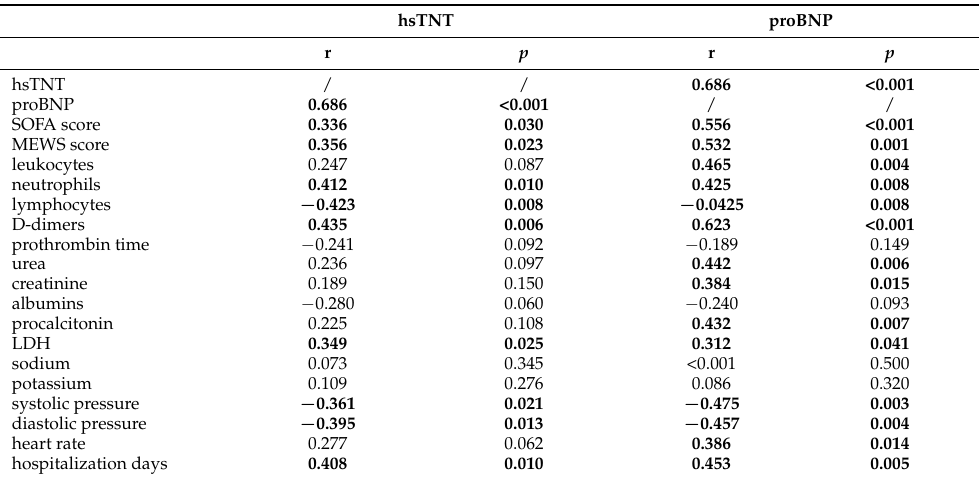
Table 2. The correlation between cardiovascular injury markers and clinical measures of the subjects (Pearson’s test, one-tailed). hsTNT proBNP r p r p hsTNT / / 0.686 <0.001 proBNP <0.001